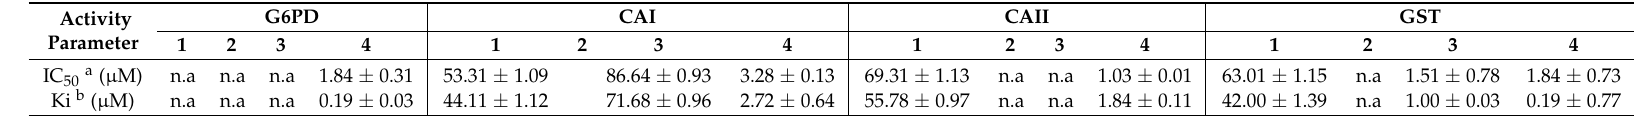
Table 2. Inhibitory parameters of isolated compounds against G6PD, CAI, CAII, and